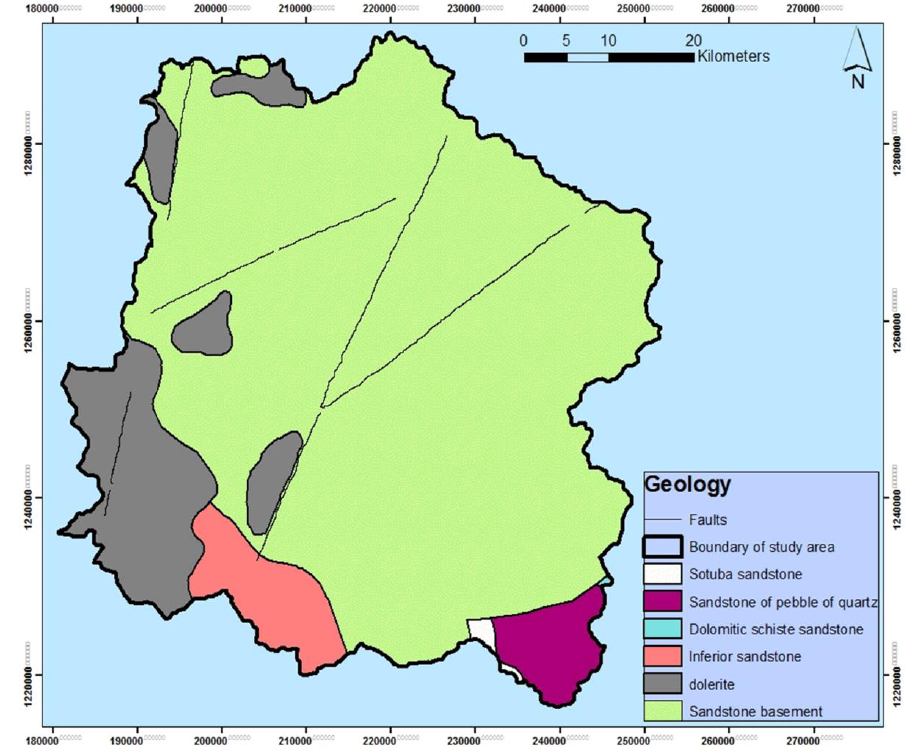
Figure 3. Geologic map of the Klela basin (adapted from DNH [18]).